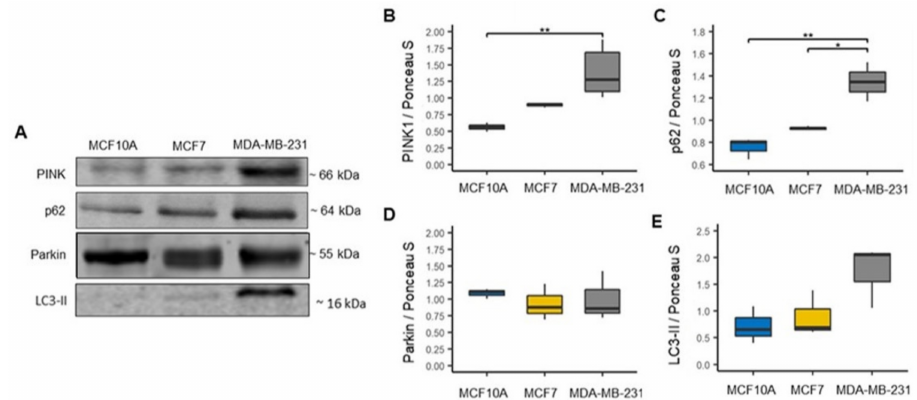
Figure 3. Increased mitophagy markers in the MDA-MB-231 cell line. ( A ) Representative blots. ( B – E ) Expression of mitophagy markers, PTEN-induced kinase 1 (PINK1), n = 6; ubiquitin-binding protein p62 (p62), n = 3; Parkin, n = 3; and microtubule-associated proteins 1A/1B light chain 3B (LC3-II), n = 3. Densitometry values were normalized by Ponceau S red staining. The data are presented as mean ± SD. * p < 0.05, ** p < 0.01.